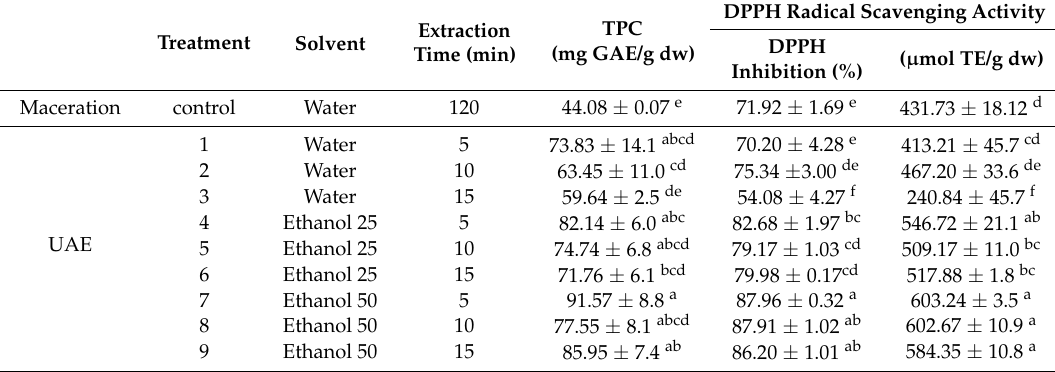
Table 1. Ultrasound Assisted Extraction parameters for 3 2 factorial design, TPC and DPPH radical scavenging